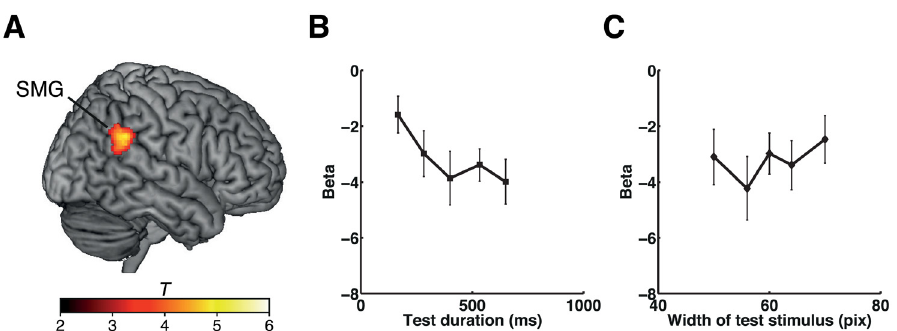
Fig 6. Effects of duration adaptation during the graded-shape task in experiment 3. (A) Results of experiment 3. The right SMG cluster showing duration adaptation effects during the graded-shape task is shown on a standard brain. Plots of the beta values at the peak coordinates of the cluster in the right SMG ( x , y , z = 60, − 44, 30) for each set of stimulus durations (B) and for each set of stimulus widths (C). The color scale indicates the T -values. Error bars indicate standard errors of the mean. Please refer to S1 Data for the numerical values underlying (B) and (C).